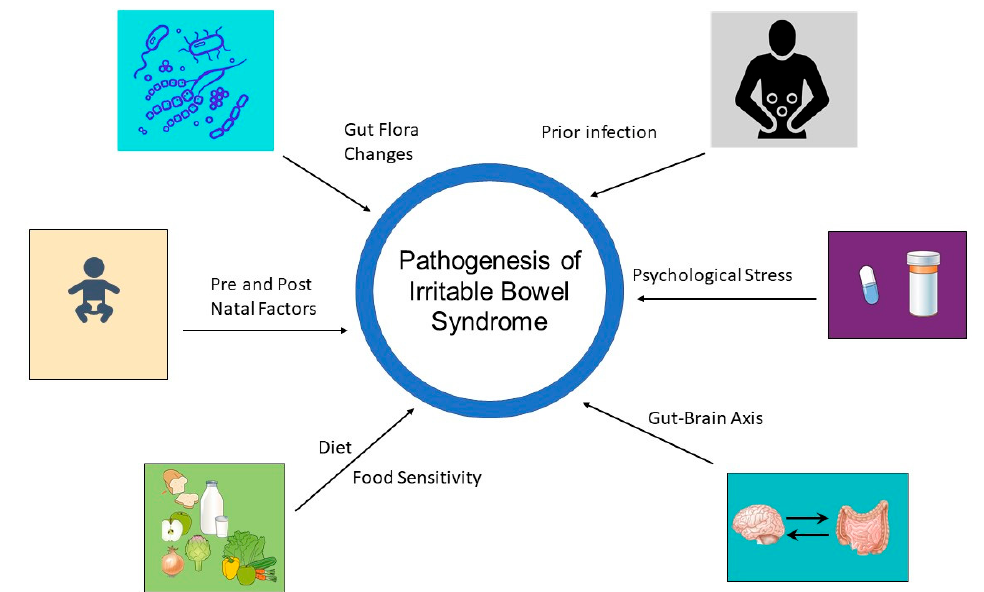
Figure 1. Elements in the Pathophysiology of Irritable Bowel Syndrome.